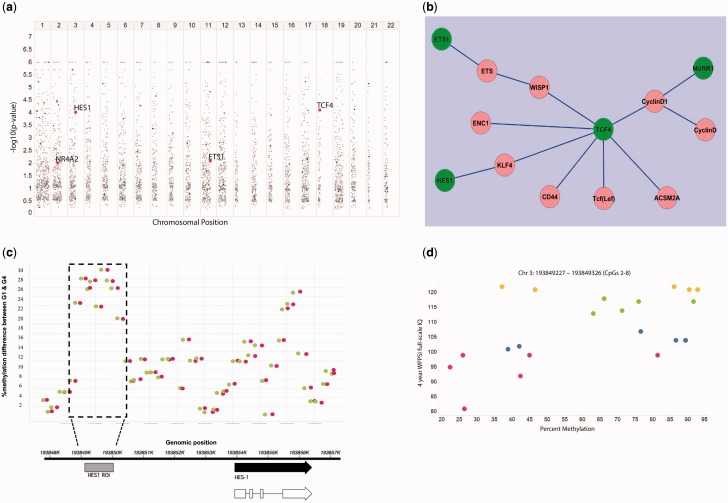
Methylation of HES1 DMR in cord at birth is associated with WPPSI IQ at 4 years of age. a) Manhattan plot of epigenome-wide methylation analysis. The X-axis indicates chromosomal position, the Y-axis the –log 10 P-value of the Fishers Exact test. The black dots represent DMROIs and those associated with HES1, NR4A2, ETS1 and TCF4 are shown in red. b) Diencephalon development pathway. Genes contained in the diencephalon development GO process were connected to each other by using the direct interactions algorithm in GeneGoMetacoreTM. Genes containing DMROIs (HES1, NURR1, ETS1 and TCF4) are denoted by green circles (NR4A2 is denoted by its alternative name NURR1). This figure is generated in Cytoscape. c) DMROI plot for HES1 (Chr 3: 193848528–193853872). X-axis shows chromosomal coordinates (hg19), Y-axis shows absolute % methylation difference between WPSSI Groups 1 and 4. Green and red circles represent start and end of each 100-nucleotide region returned from BATMAN, respectively; 100 nucleotide regions in the dotted box were found to have >20% absolute methylation difference between WPSSI Groups 1 and 4 and this region was selected for pyrosequencing in the extended sample set. The lower panel shows the positions of the HES1 transcript and the upstream DMROI. d) Concordance of methylation values with WPSSI scores for the 100-nt region within the HES1 ROI selected for pyrosequencing (containing CpGs 2–8), upstream of the HES1 coding sequence. X-axis shows WPSSI scores and Y-axis shows % methylation as estimated by the Bayesian algorithm BATMAN. Sample data points are coloured by WPSSI groups (red = Group 1, lowest WPSSI scores; blue = Group 2, low WPSSI scores; green = Group 3, high WPSSI scores; yellow = Group 4, highest WPSSI scores). Chromosomal coordinates of the region are detailed above the figure. WPPSI = Wechsler Pre-School and Primary Scale of Intelligence (full-scale IQ).